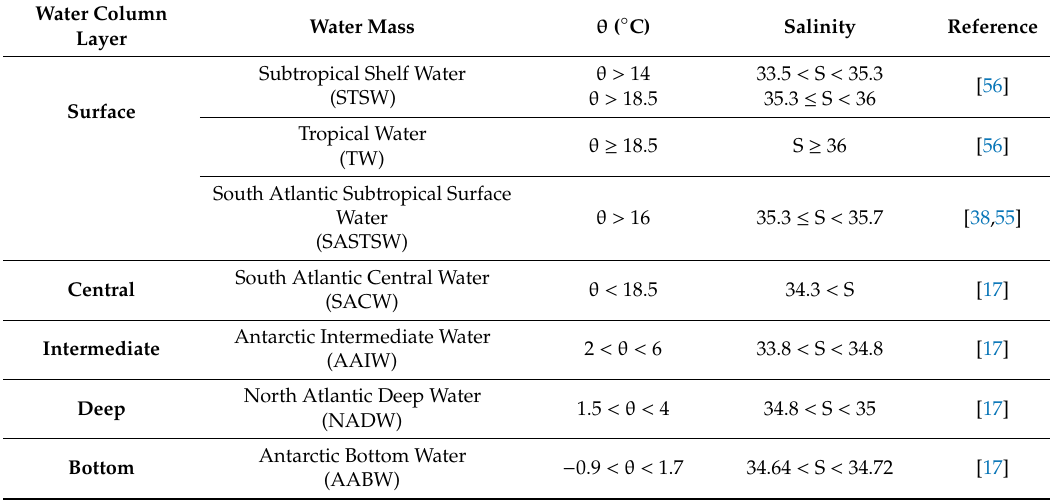
Table 3. Thermohaline ranges used to characterize the water masses observed in this study, including their positions in the water column layer and